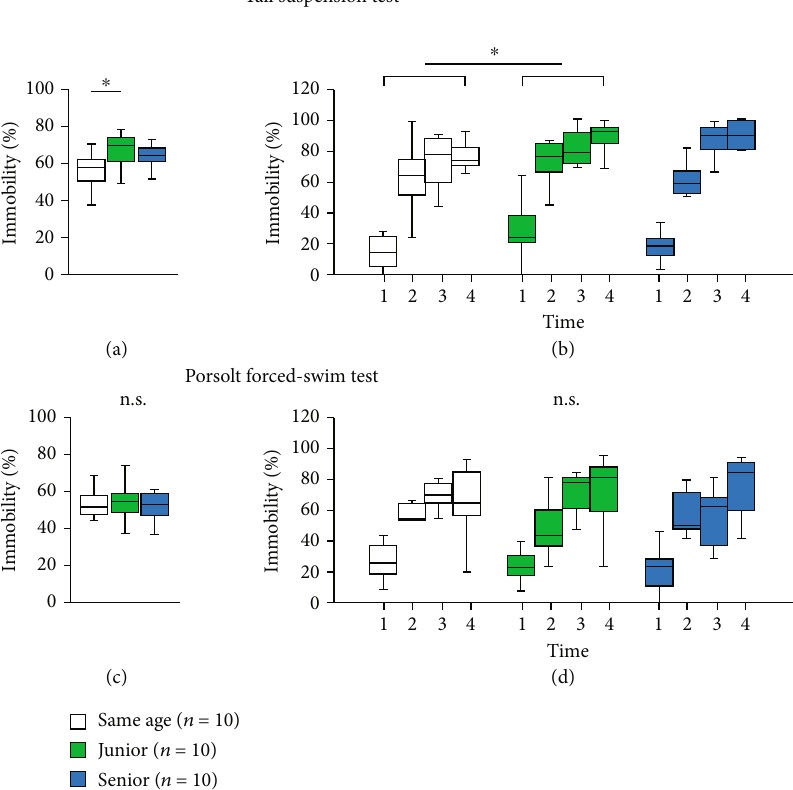
Figure 6: E ff ect of group housing condition on depressive-like behavior. Graphs showing the proportion of total time spent immobile (a) and the proportion of time spent immobile in each 1 min period (b) in the tail-suspension test. Graphs showing the proportion of total time spent immobile (c) and the proportion of time spent immobile in each 1 min period (d) in the Porsolt forced-swim test. All data are presented as box plots. ∗ Signi fi cant di ff erence in comparison with controls ( p < 0 : 05 ). The p values were calculated using the two-way ANOVA in (a) and (c), and two-way repeated measures ANOVA in (b) and